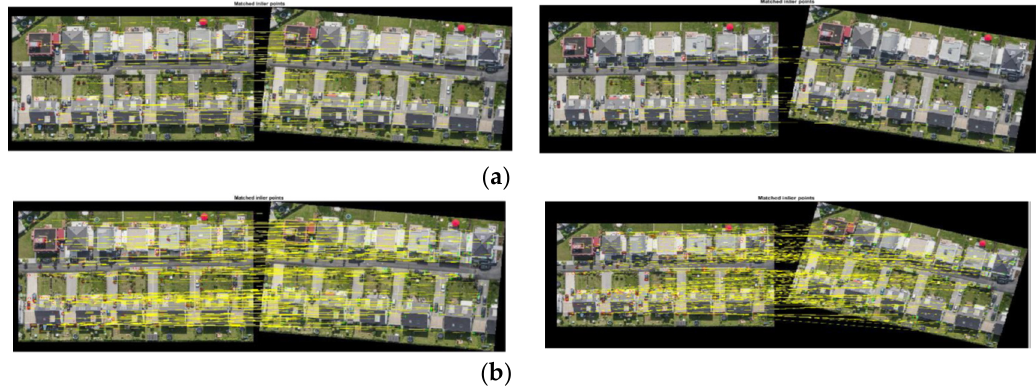
Figure 7. Matching result between the original image and the 5° and 10° rotated images using ( a ) SYBA and ( b ) rSYBA. Table 1. Accuracy comparison for Scale Image Sequence. Table 2. Accuracy comparison for Rotation Image Sequence.